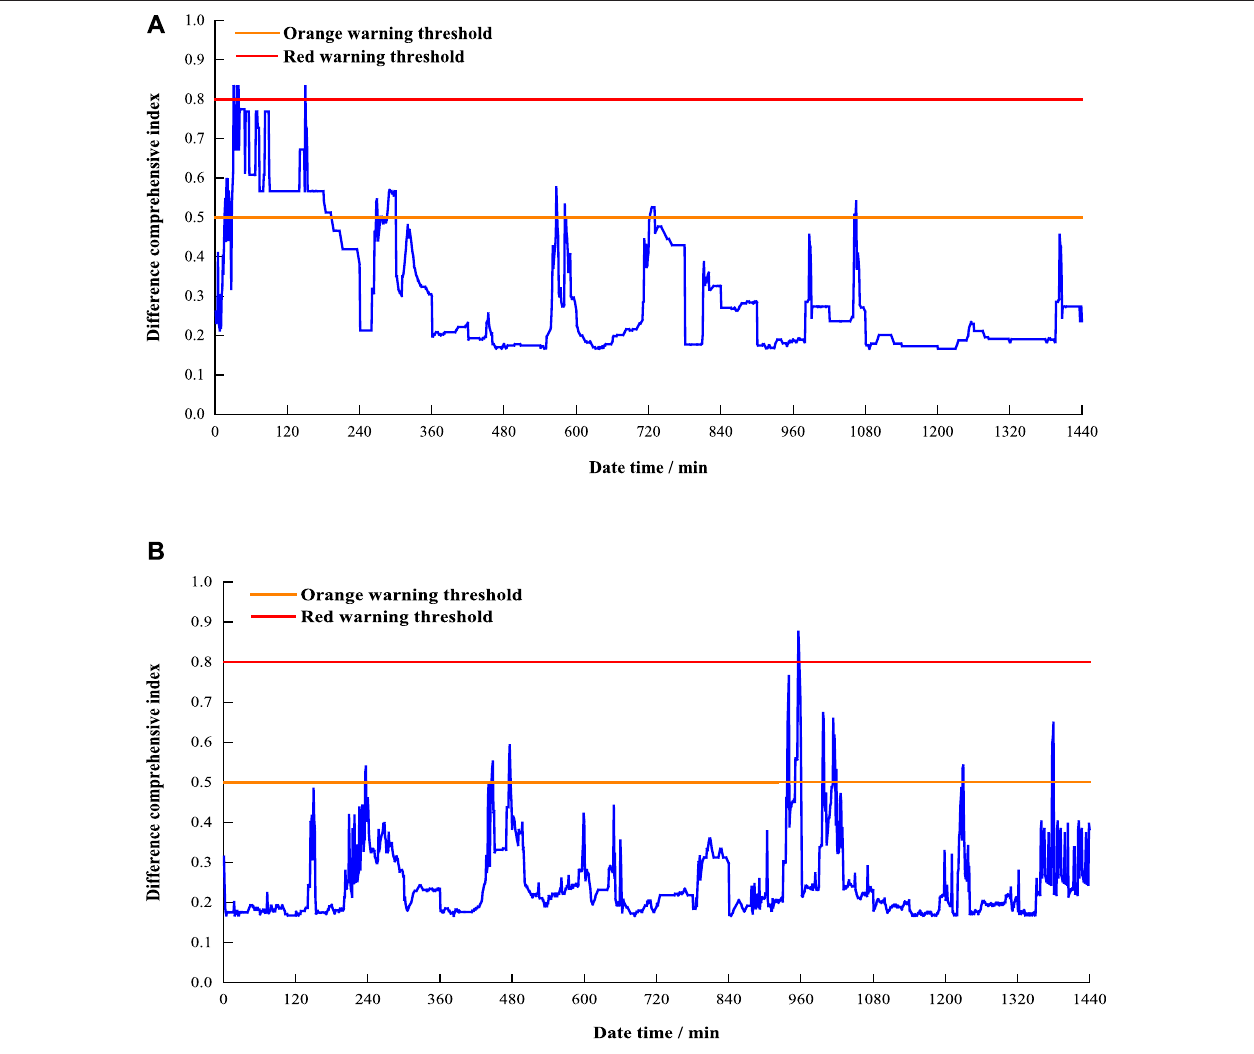
FIGURE 17 | Prominent warning results validation analysis. (A) Outburst warning results of on Dongfeng coal mine (B) Outburst warning results of on Hebi Six Mineral.